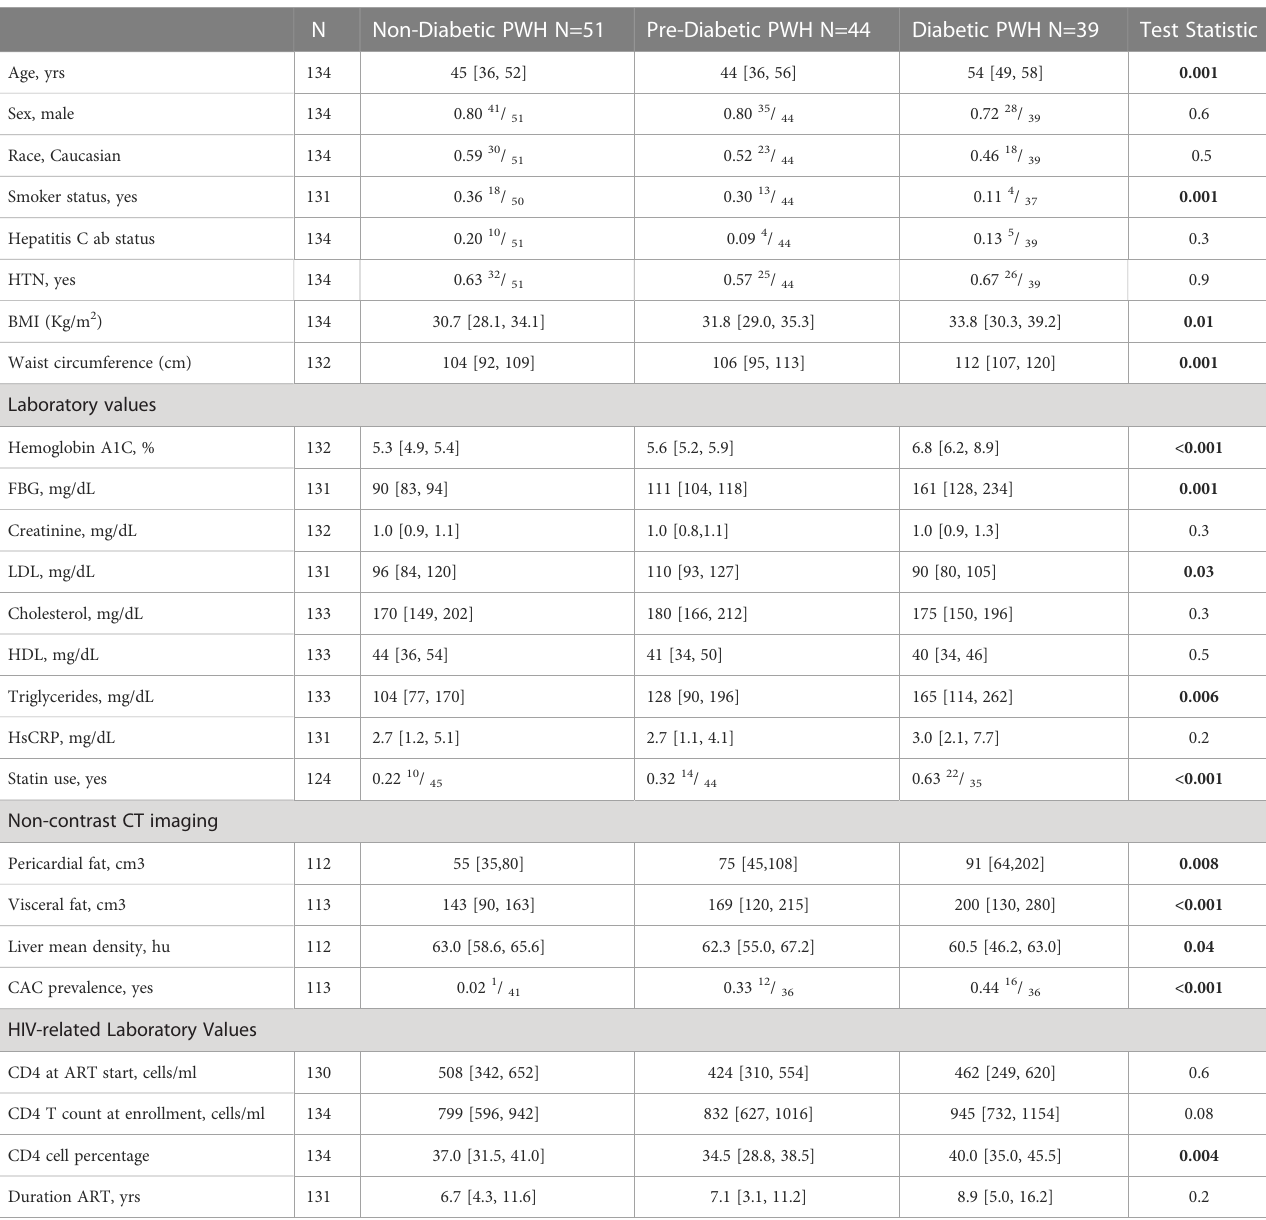
TABLE 1 Clinical and demographic characteristics of the study